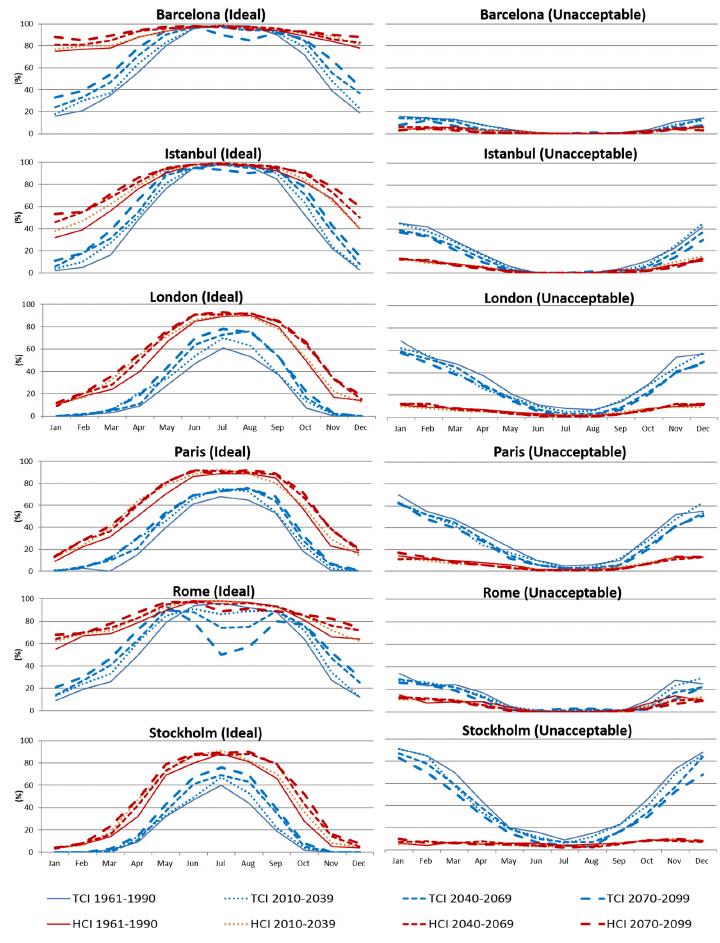
Figure 1. Current and projected Tourism Climate Index (TCI) and Holiday Climate Index (HCI:Urban) mean monthly scores of six European city destinations.